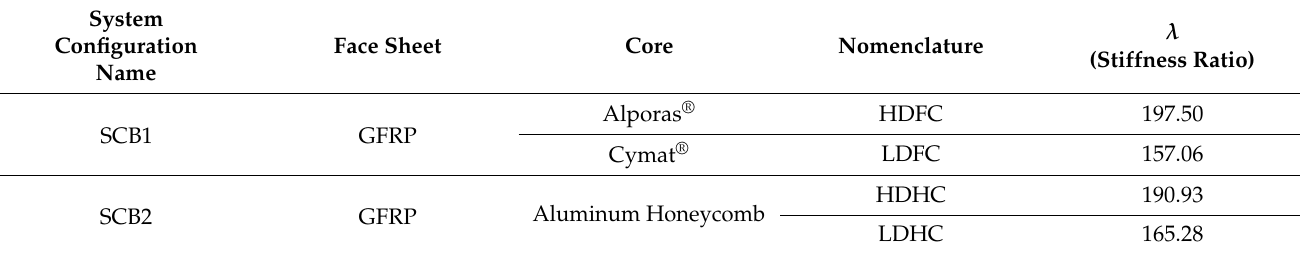
Table 4. Stiffness ratio λ for different material